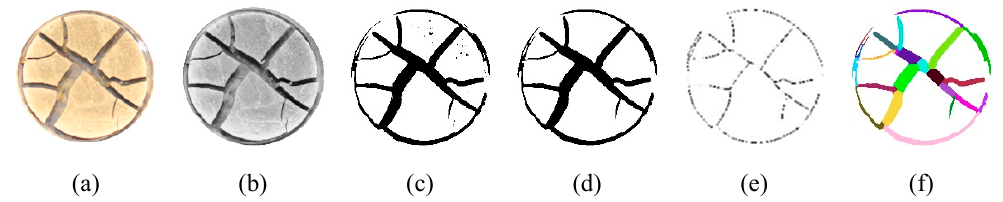
Figure 3. Procedure of digital image processing: ( a ) original image, ( b ) grey image, ( c ) binary image, ( d ) clear noise and smoothing, ( e ) skeleton of the crack network, and ( f ) crack segmentation.